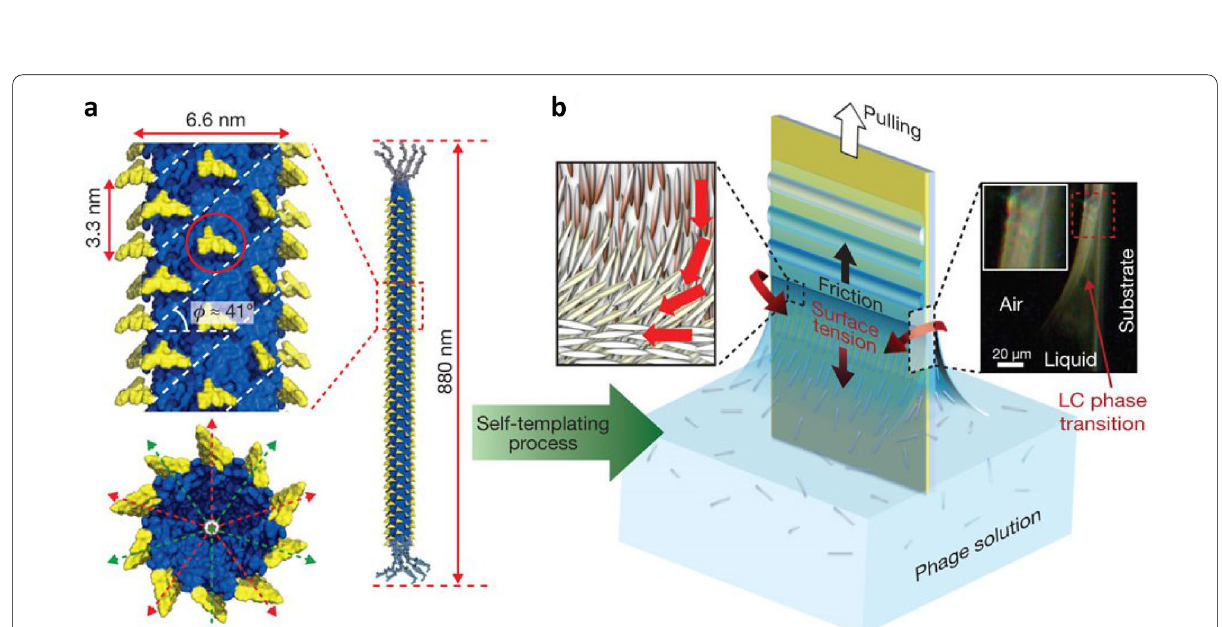
Fig. 2 Schematic diagram of the M13 bacteriophage‑based autologous template process. a Schematic diagram (red and green arrows) of a bacteriophage structure covered with approximately 2700 α ‑helix main capsule (pVIII) protein subunits with five‑helix symmetry and a double‑thread axis of rotation. The bacteriophage has a helix angle ( φ ) of 41 ◦ and the periodic subunit spacing is 3.3 nm. The red circle represents the target receptor to recognize target molecules. b Schematic of the helical self‑template assembly of bacteriophage particles controlled by competing interfacial forces in the meniscus where the liquid crystal phase transition occurs. Polarized light microscopy images show iridescent colours resulting from the formation of liquid crystal phases at the air–liquid–solid interface ( a , b Reproduced with permission from Ref.